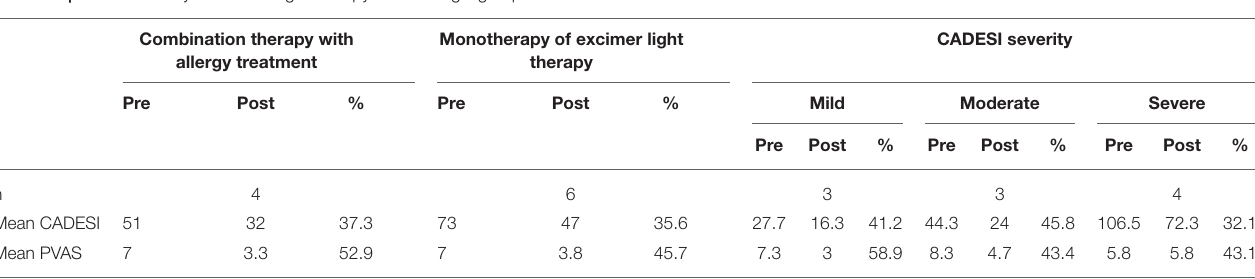
TABLE 4 | Clinical efficacy of excimer light therapy in the allergic group. Combination therapy with allergy treatment